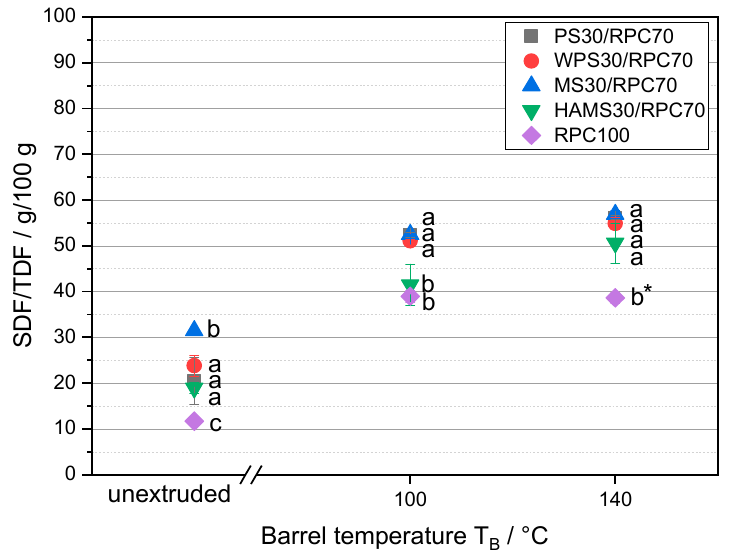
Figure 6. Ratio of soluble (SDF) to total (TDF) dietary fiber (SDF/TDF) of rapeseed press cake (RPC100) and RPC/starch blends containing potato starch (PS), waxy potato starch (WPS), maize starch (MS) or high ‐ amylose maize starch (HAMS) as a function of barrel temperature T B (unextruded, 100 °C, 140 °C). Mean values with different superscript letters indicate significant differences ( p < 0.05) between the blends based on a two ‐ way analysis of variance (ANOVA). Where appropriate, the mean values were compared using Tukey’s honest significance test. * Extruded at 120 °C.